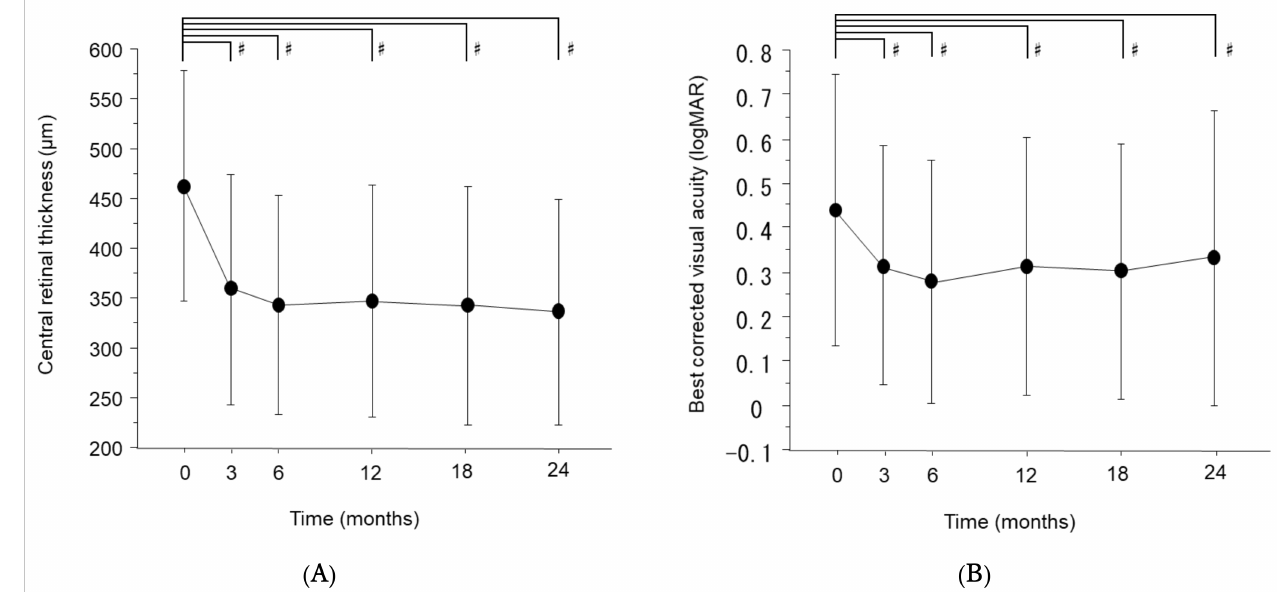
Figure 1. Changes in central retinal thickness (CRT) and best-corrected visual acuity (BCVA) after initiation of anti-vascular endothelial growth factor (VEGF) therapy. ( A ) CRT and ( B ) BCVA were measured at 0 (baseline), and 3, 6, 12, 18, and 24 months after initial injection of anti-VEGF agents. BCVA is expressed as the logarithm of the minimal angle of resolution (logMAR). Data are represented as means ± standard deviations (SD). # p < 0.05 (versus baseline by Steel’s multiple-comparison